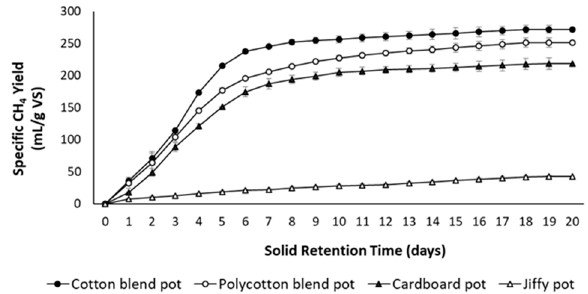
Figure 14. Specific methane yield of seedling pots.